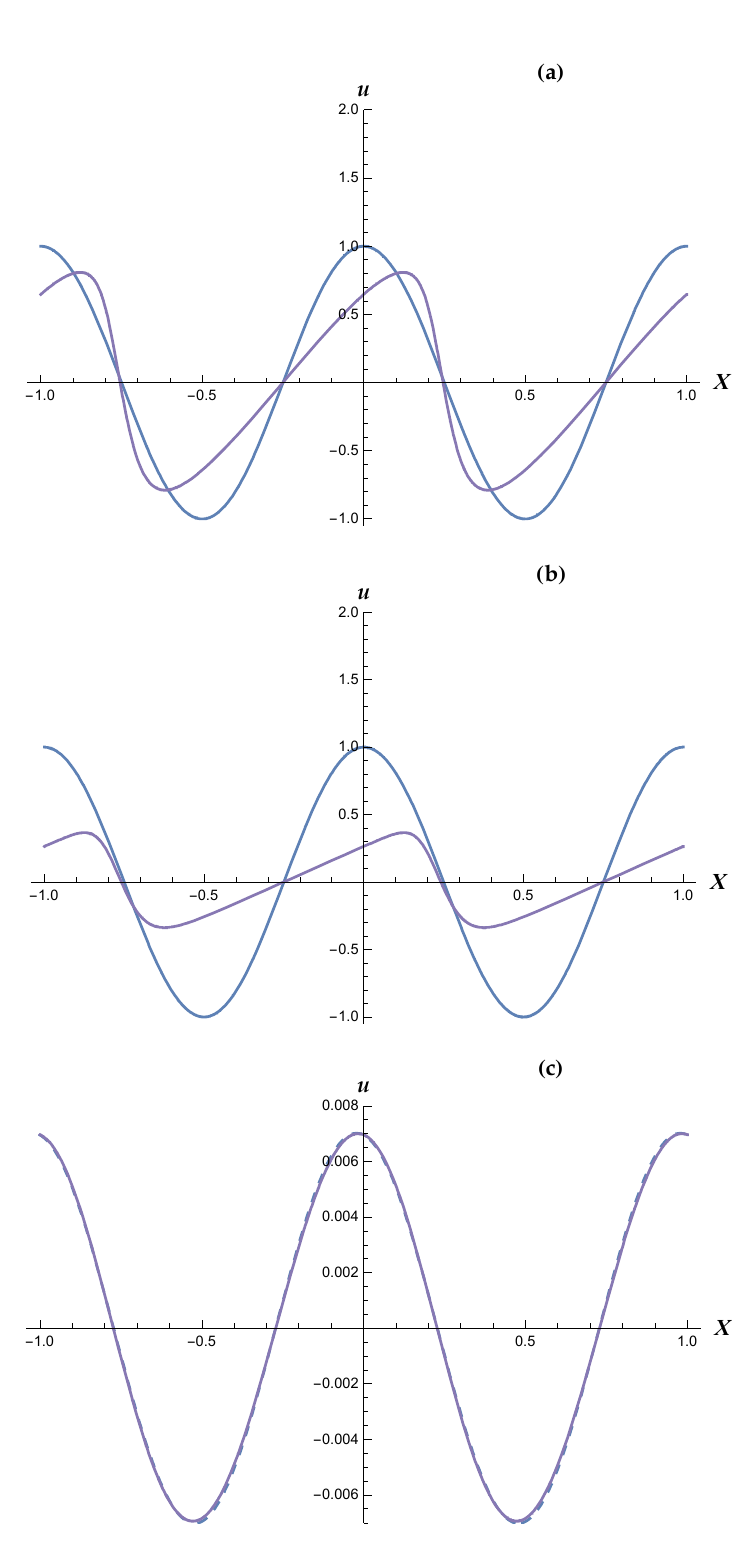
Figure 2. The dBKdV case of IBVP (30). ( a – c ) correspond to T = T ∗ ≈ 1.382. Purple curves: u vs. X for a where T ∗ B α (cid:63) = 0.5. Blue curves (solid): IC given in Equation (30c). Blue-broken curve: u 1 ( X ,20 T ∗ Equation (31)), where we have set of trial-and-error “visual